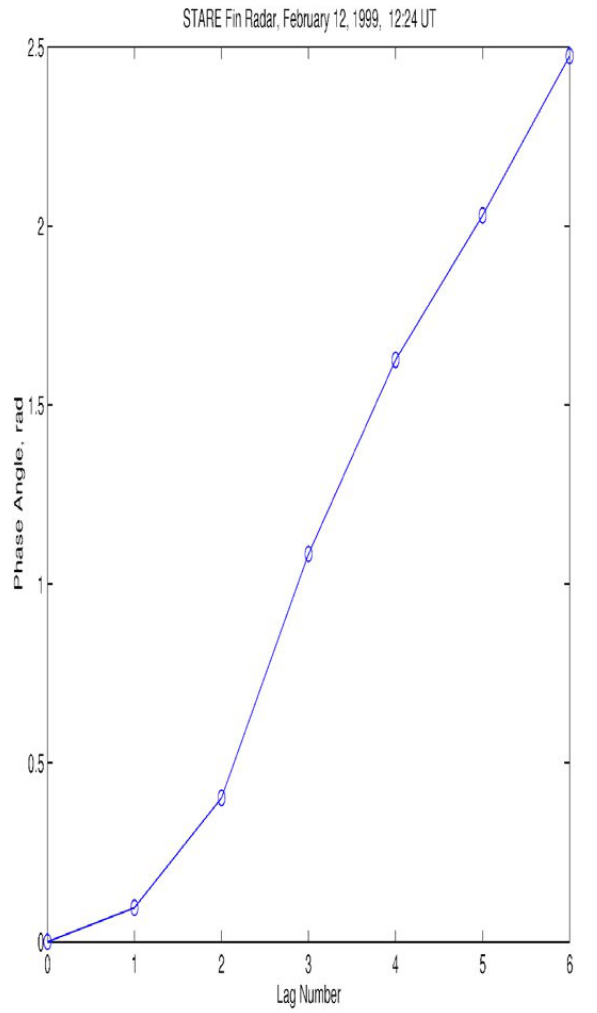
backscattered power